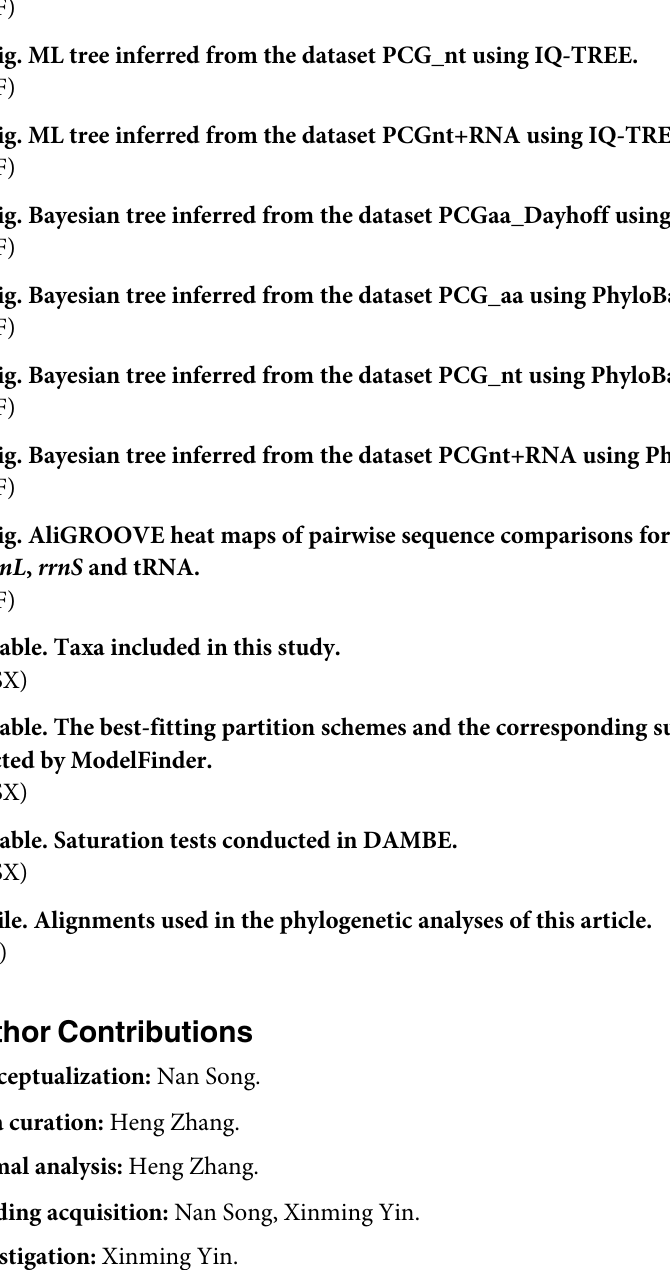
S6 Fig. Bayesian tree inferred from the dataset PCG_aa using PhyloBayes.